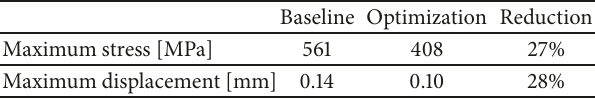
Table 5: 2D impeller optimization